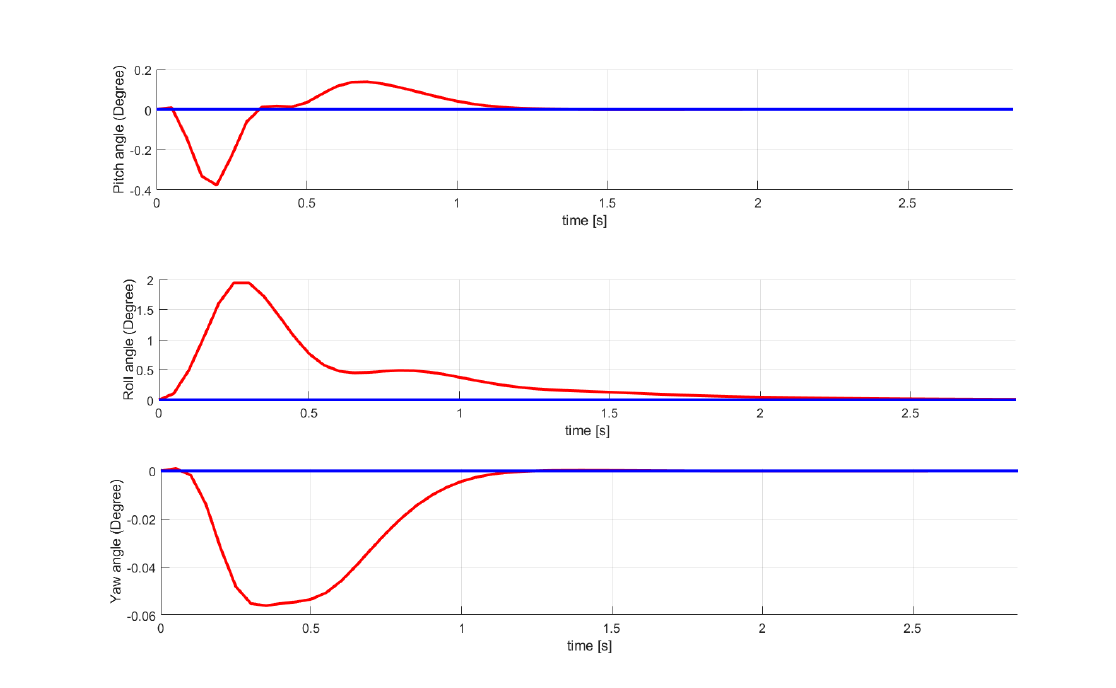
Figure 8. Simulation curves of the quadrotor states in hovering stable tests.